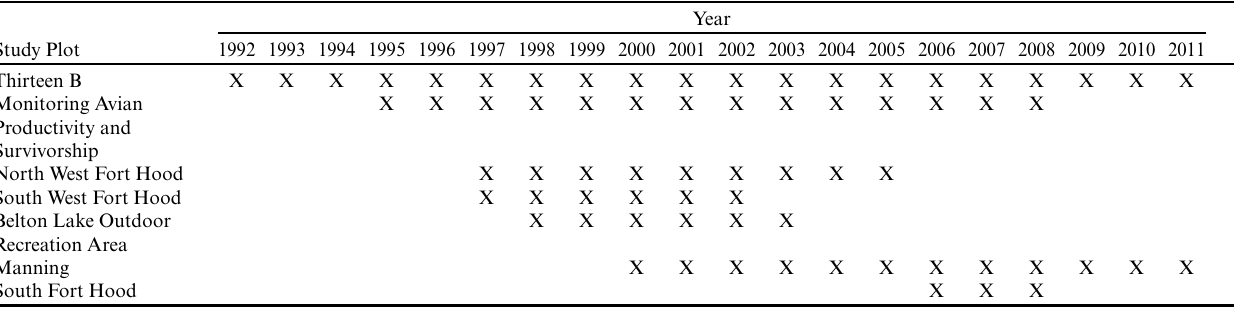
Table 1 . Years and study plots where Golden-cheeked Warbler ( Setophaga chrysoparia ) surveys were conducted by the Nature Conservancy and Monitoring Avian Productivity and Survivorship programs on the Fort Hood Military Reservation, Texas, USA. Banding and monitoring efforts were conducted from April through June. Table excludes 1991 because study plots were not delineated until 1992.